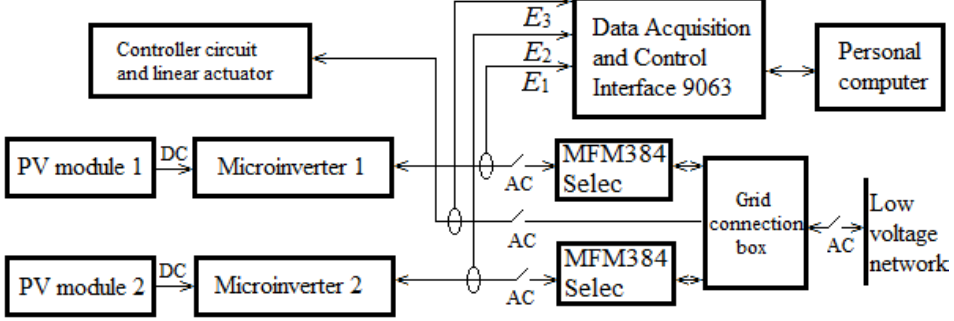
Figure 3. Block diagram of the measurement system (MFM: multifunction meter).